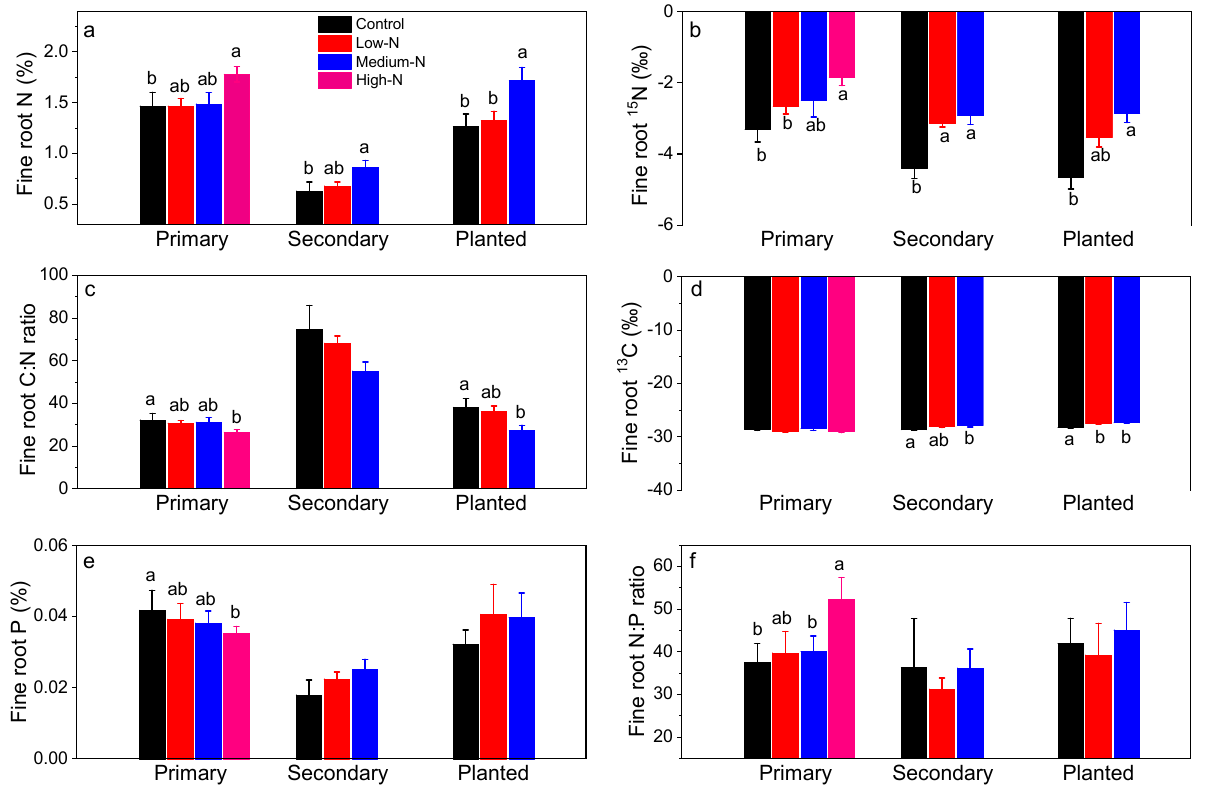
Figure 4. Fine root N concentration (%, a ), 15 N signature (‰, b ), C:N ratio ( c ), 13 C signature (‰, d ), P concentration (%, e ), and N:P ratio ( f ) after 8 years of low-N, medium-N, and high-N treatments in the three forests of southern China. 15 N signature of N source (NH 4 NO 3 ) was 3.6‰ (±0.03‰). Different lowercase letters indicate significant differences among treatments ( p < 0.05). Error bars show SE (n = 3).